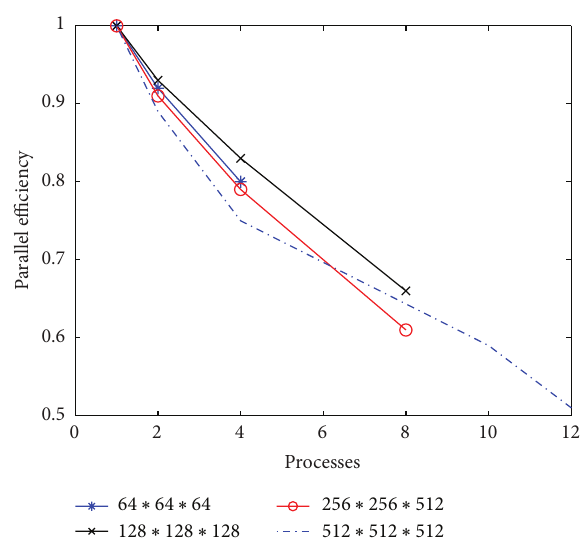
Figure 5: Parallel efficiency of different case.